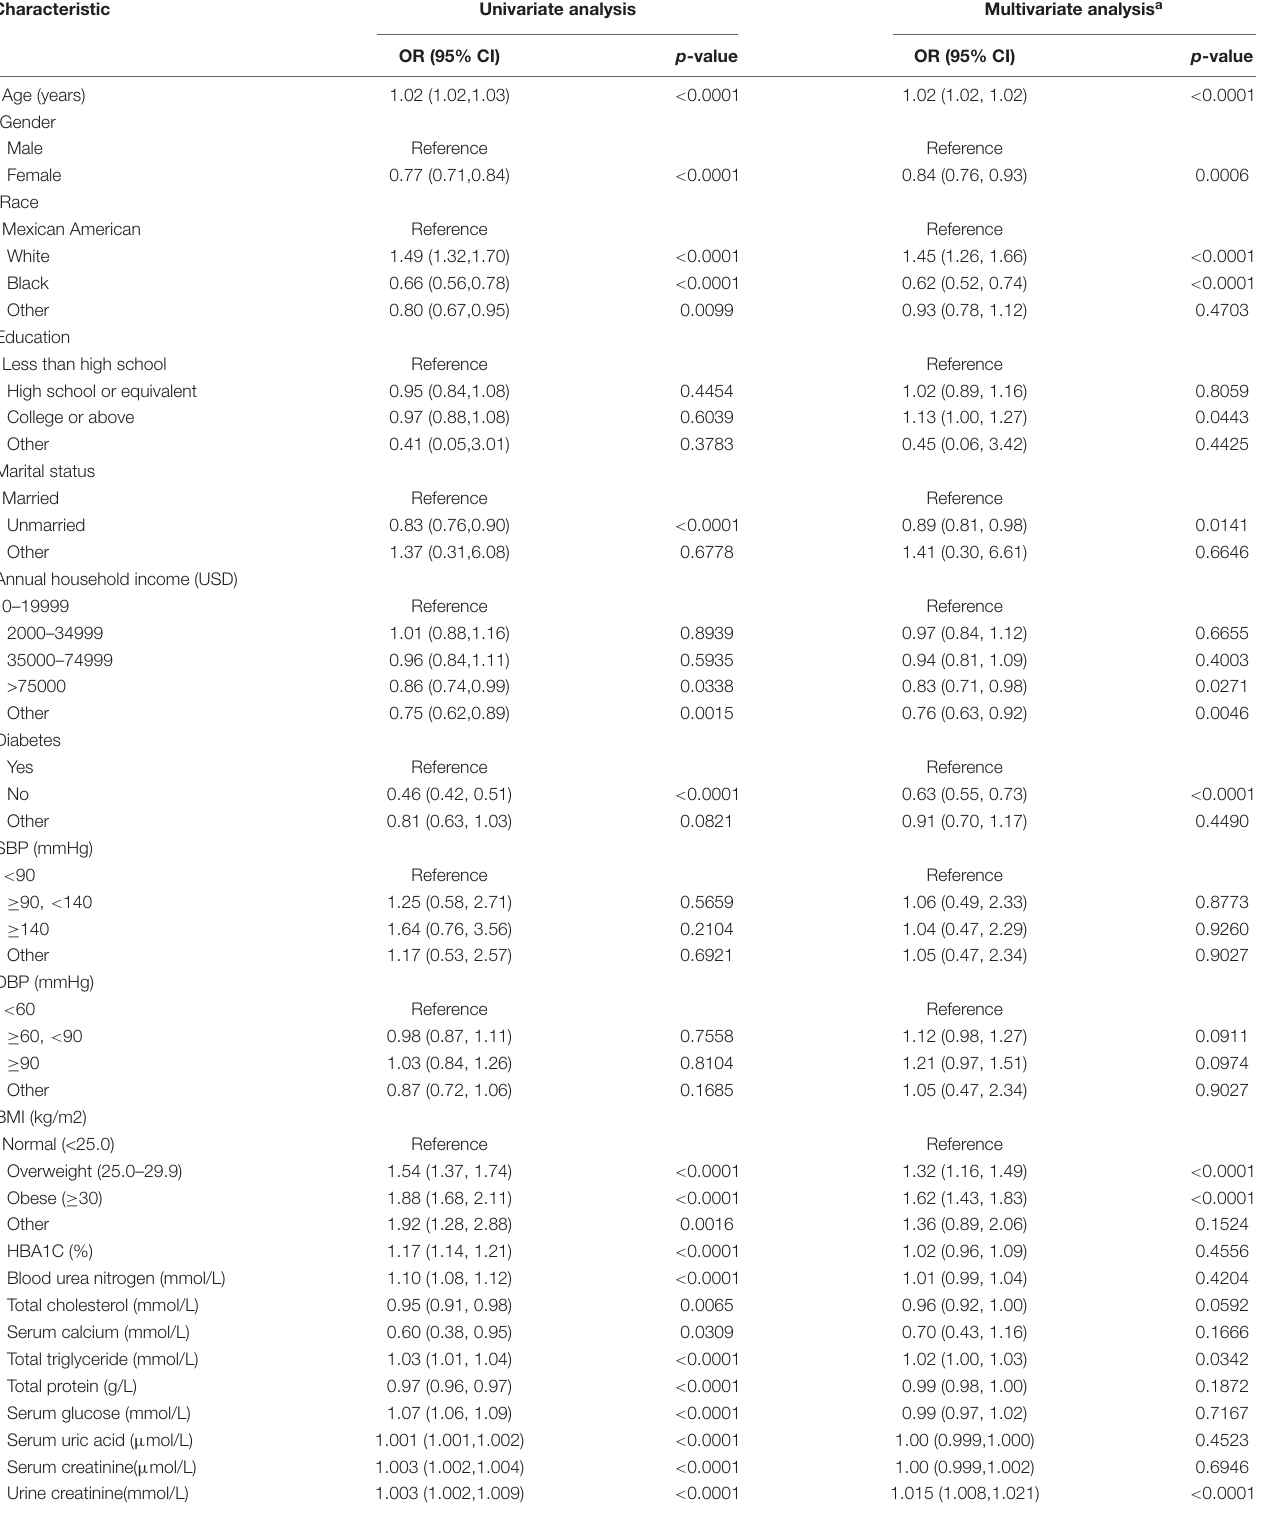
TABLE 2 | Analysis between confounders and renal stone